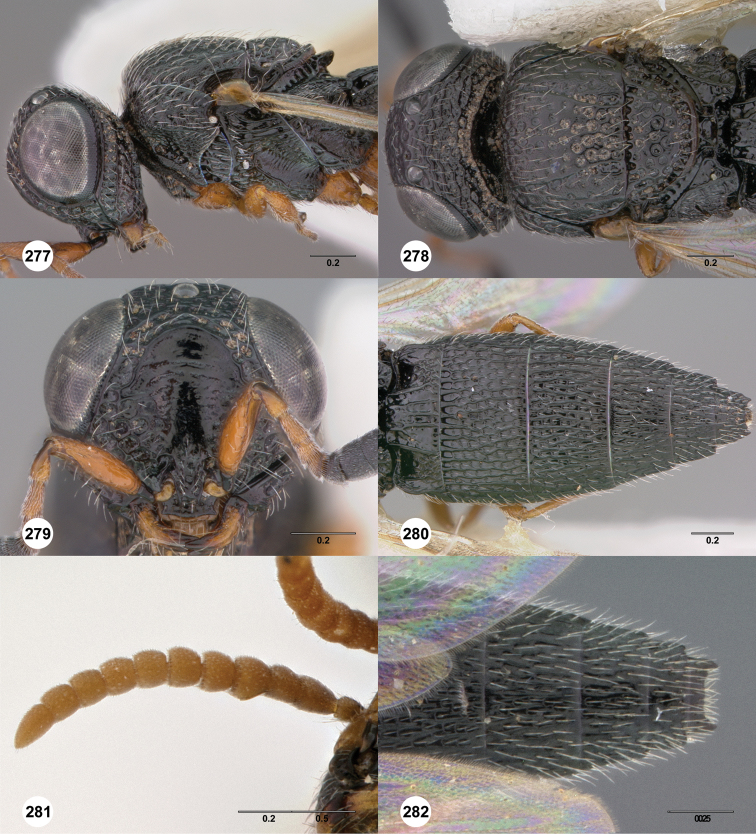
Oxyscelio rami sp. n., holotype female (OSUC 148356) 277 Head and mesosoma, lateral view 278 Head and mesosoma, dorsal view 279 Head, anterior view 280 Metasoma, dorsal view. Paratype male (OSUC 448602) 281 Antenna 282 Metasoma, dorsal view. Morphbank81